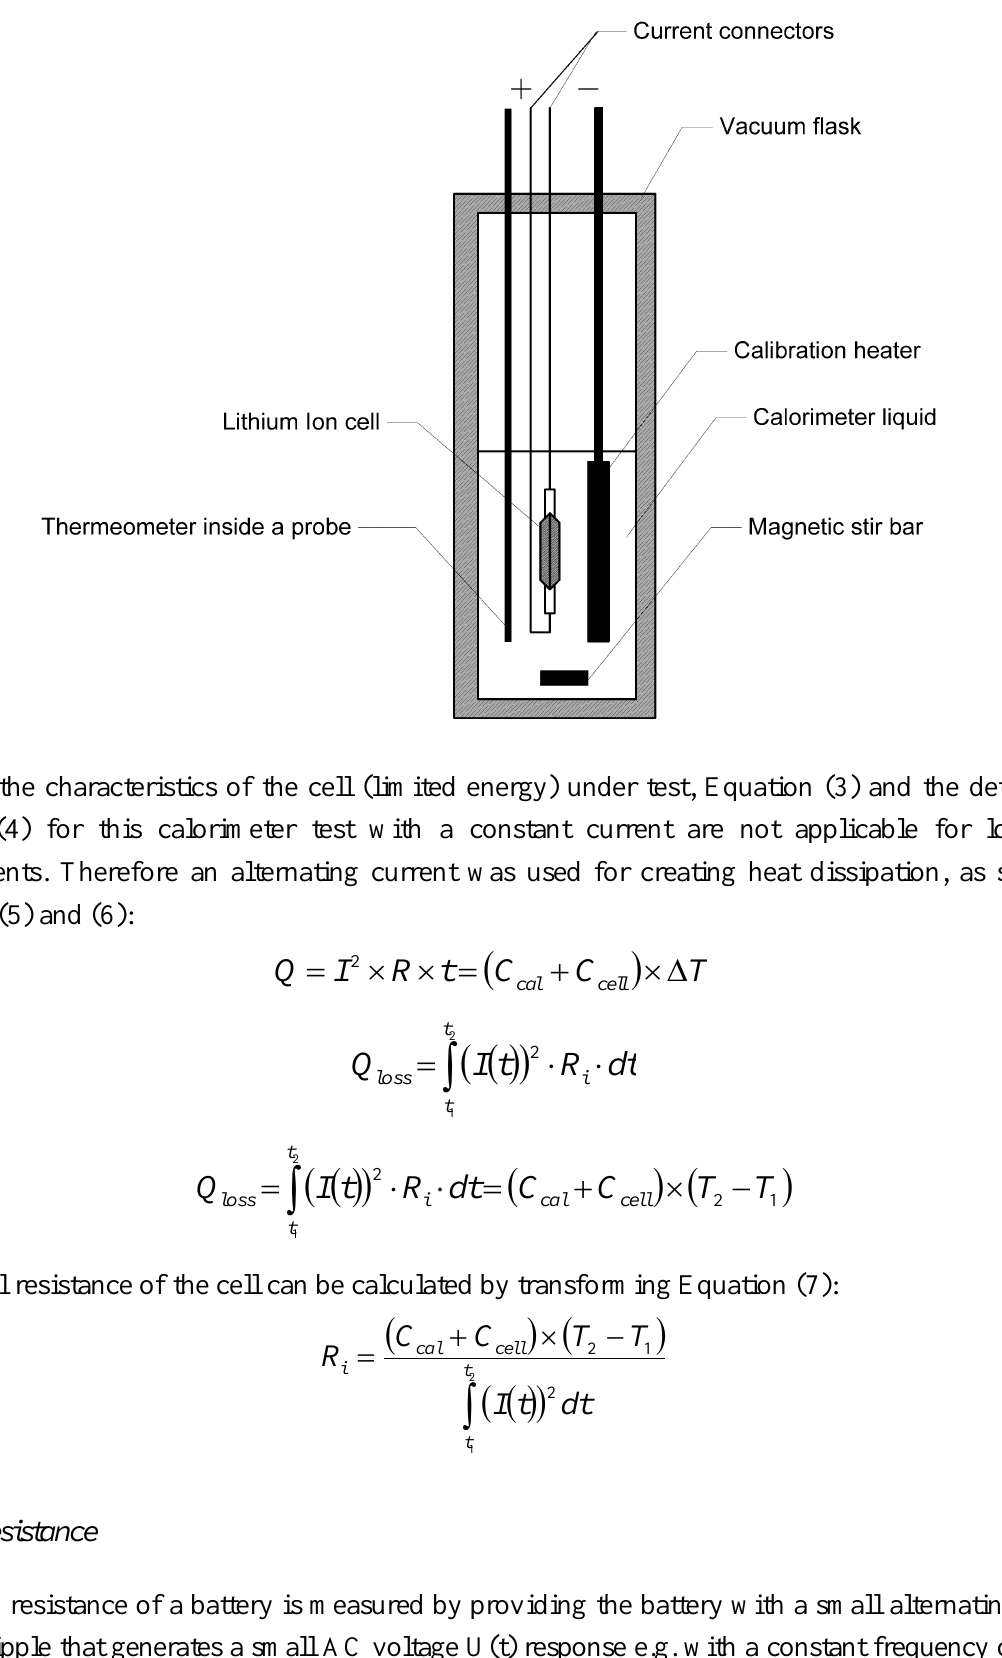
Figure 1. Quasi-adiabatic calorimeter used for determination of battery heat